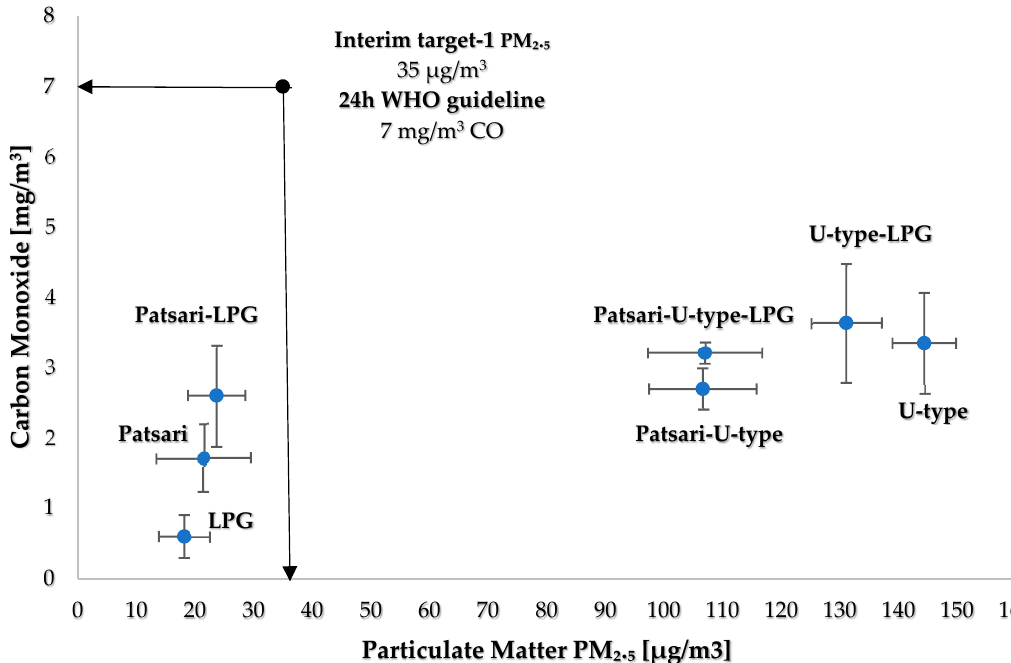
Figure 3. Average 24-h CO and PM 2.5 concentrations for CCC. The blue dots represent concentration averages and whiskers are ± 1 standard deviation of the measurements.